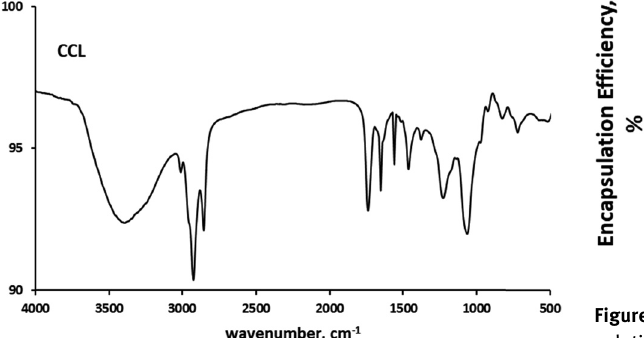
Figure 4: Fourier transform infrared spectra of CCL.